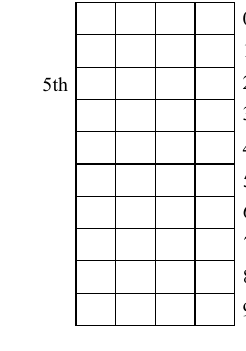
Figure 14. Arranging the order of the detection.